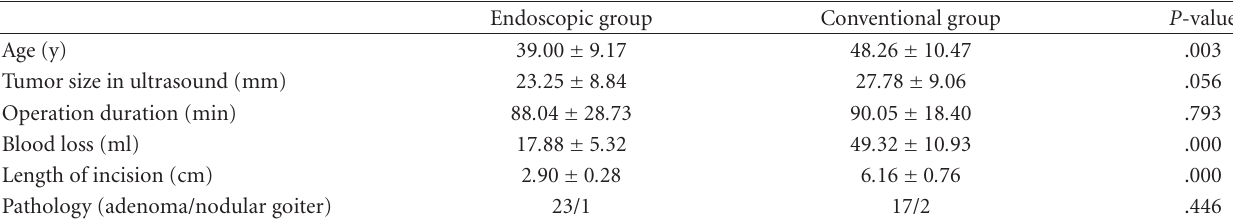
Table 1: Clinical data of the